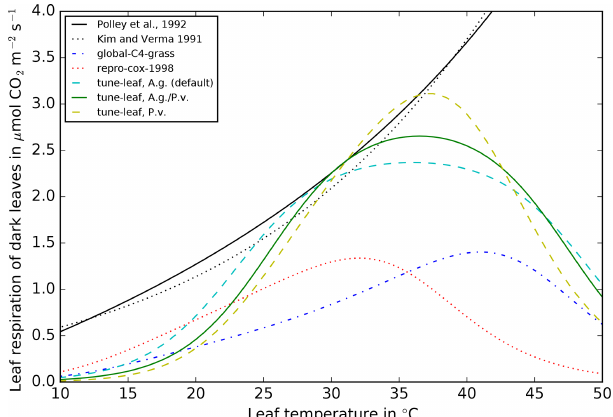
Figure 7. Comparison of leaf dark respiration against leaf temper- ature relations from Polley et al. (1992) (black solid line) Kim and Verma (1991a) (black dotted line), repro-cox-1998 (red dotted line), global-C4-grass (blue dot-dashed line), tuned to A. g. (cyan dashed line), tuned to P. v. (yellow dashed line) and tuned to both A. g. and P. v. (green solid line). All lines assume no light inhi- bition of respiration. All JULES lines are top of the canopy (TOC) values without water stress. The lines that reproduce JULES con- figurations have been calculated using the Leaf Simulator